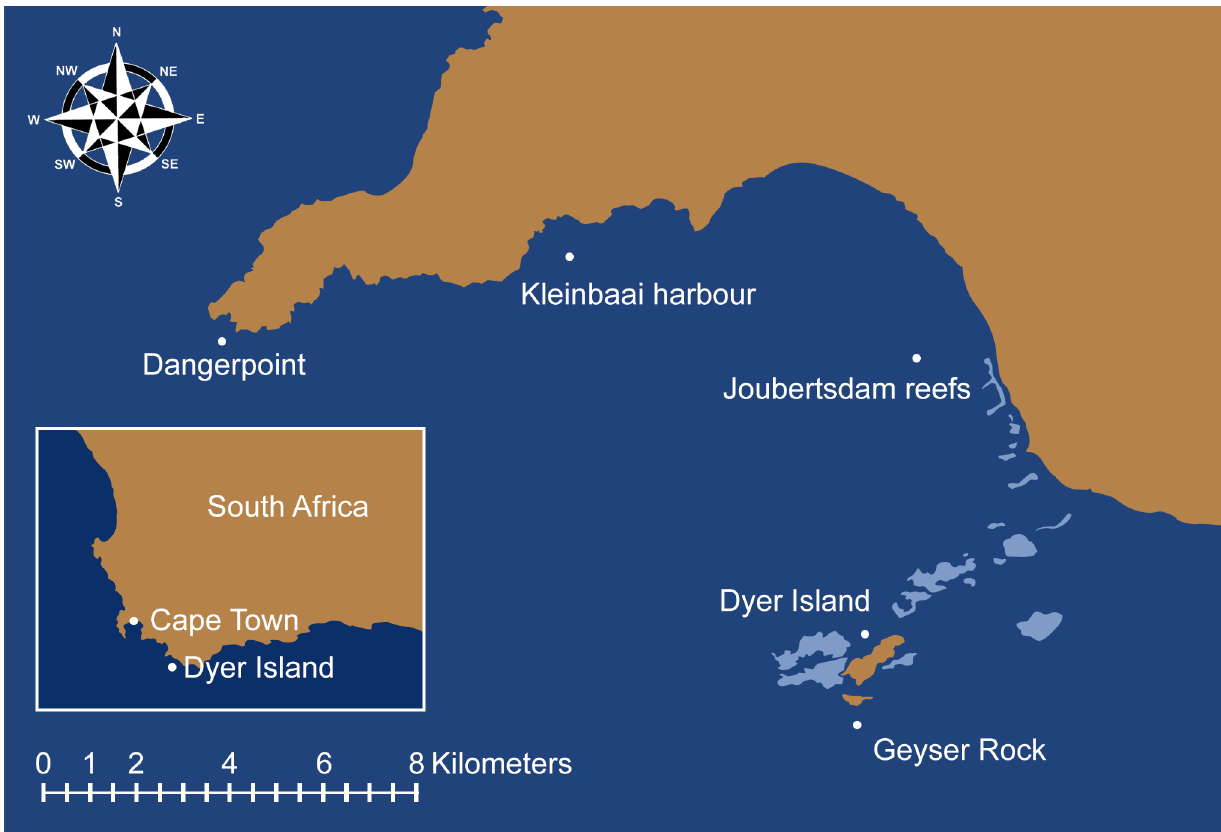
Figure 1. Site Map showing the inshore and island region of Gansbaai. This image was created by EDNA Interactive Ltd trading as EDNA: